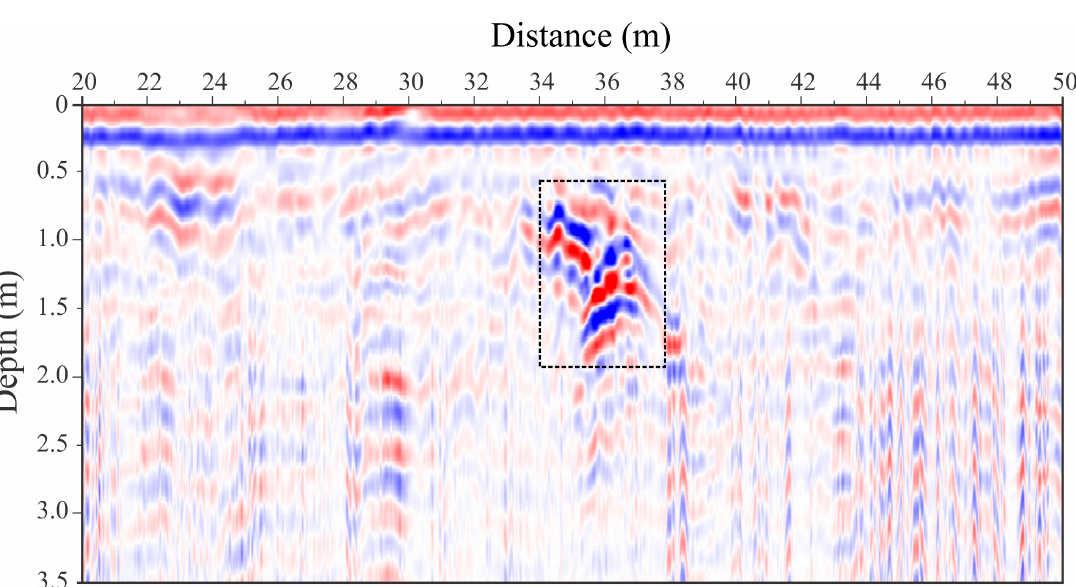
Figure 7. Segment of the GPR 2 profile of 200 MHz acquired in area 1. The black dashed rectangle highlights the anomalous region.